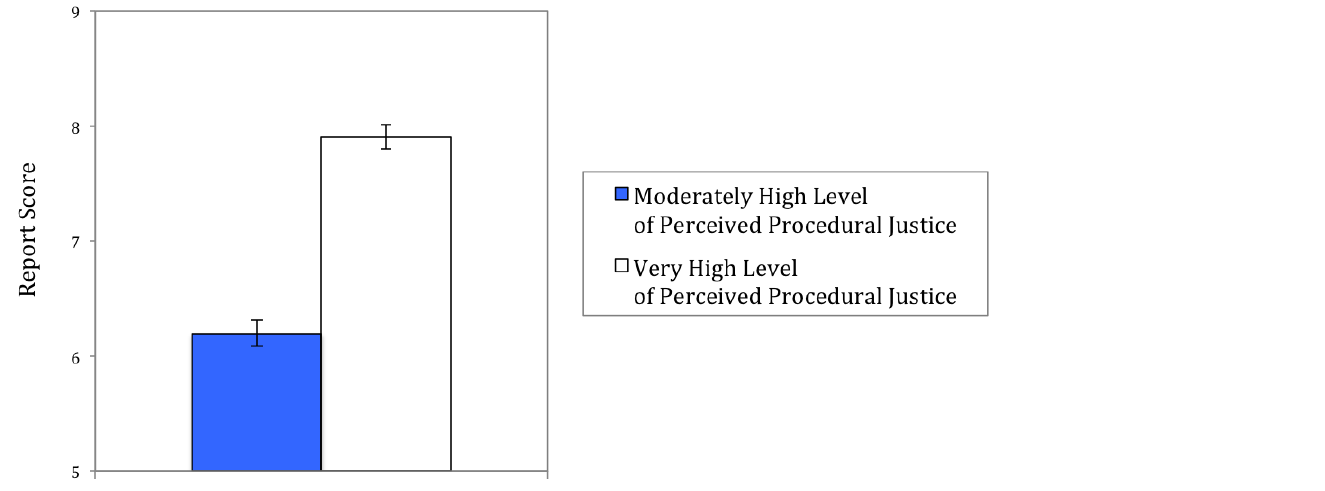
Figure 2 . Report scores awarded by citizens for the handling of their cases as a function of their perceptions of procedural justice (moderately high level [-1 SD ] versus very high level [+1 SD ]). Scores are on 10-point scales with higher values indicating higher scores of how the case was handled. Error bars represent standard errors of the